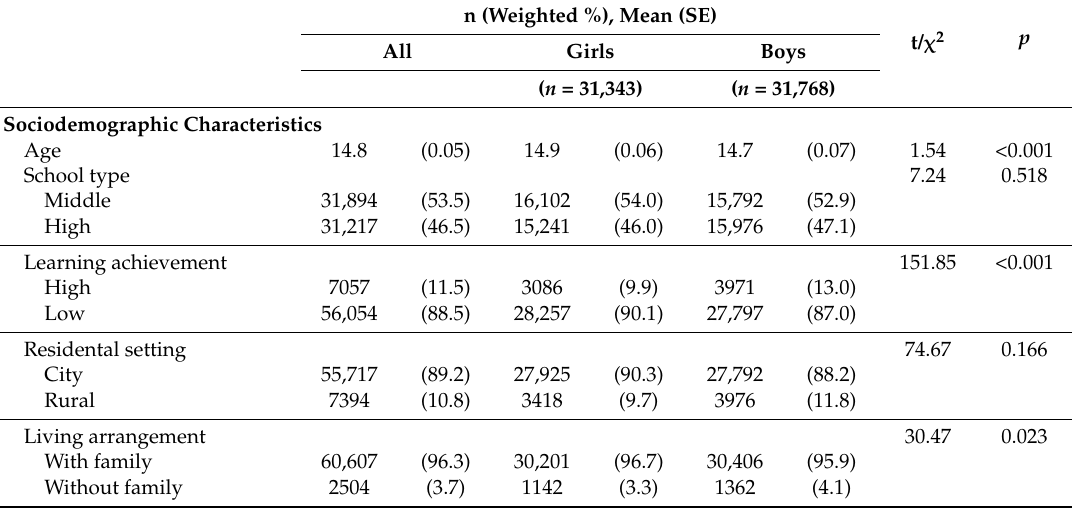
Table 1. Participants’ general characteristics ( n = 63,111), wn =